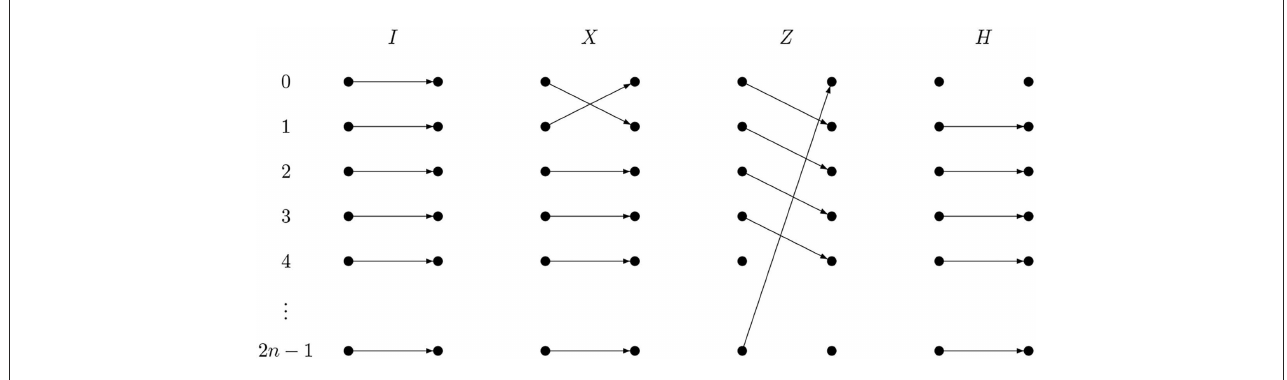
FIGURE3 Permutations induced by the letters I , X , Z , and H .